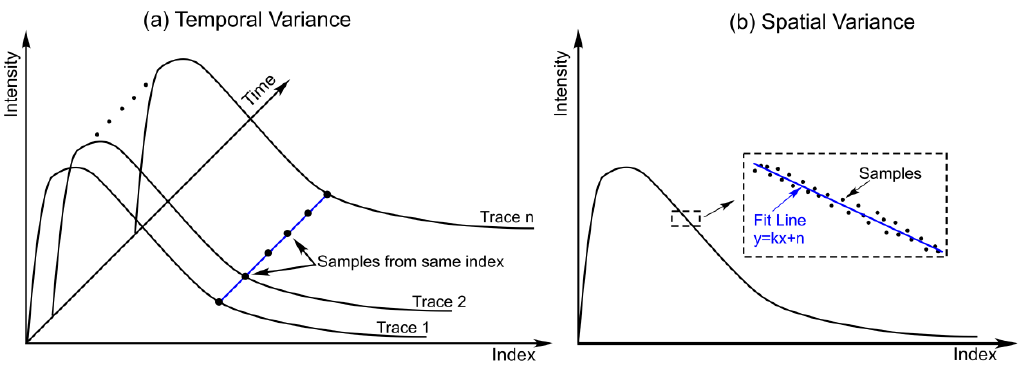
Figure 1. Schematic diagram of the calculation models of ( a ) temporal variance and ( b ) spatial variance.